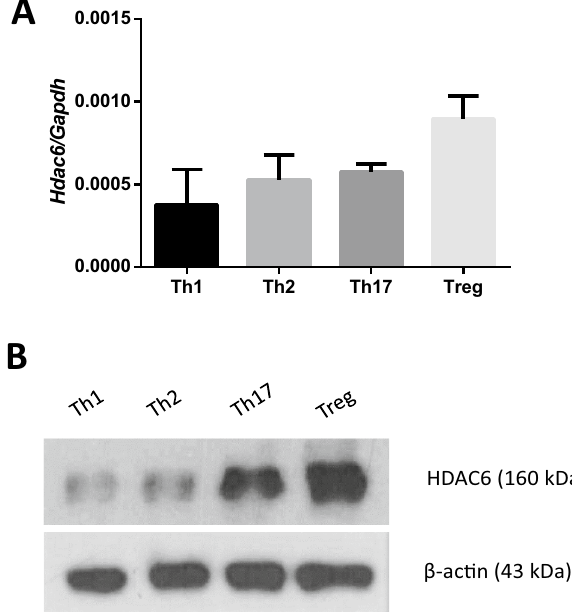
Figure 1. HDAC6 expression by different CD4 T cell subsets. ( A , B ) Naïve CD4 + T cells were isolated from mouse spleens and differentiated for 3 days into Th1, Th2, Th17, and Treg subsets. Relative expression of Hdac6 mRNA was measured by qRT-PCR ( A ), and HDAC6 protein levels were measured by immunoblot analysis ( B ). qRT-PCR data are representative of three independent experiments. Error bars represent the